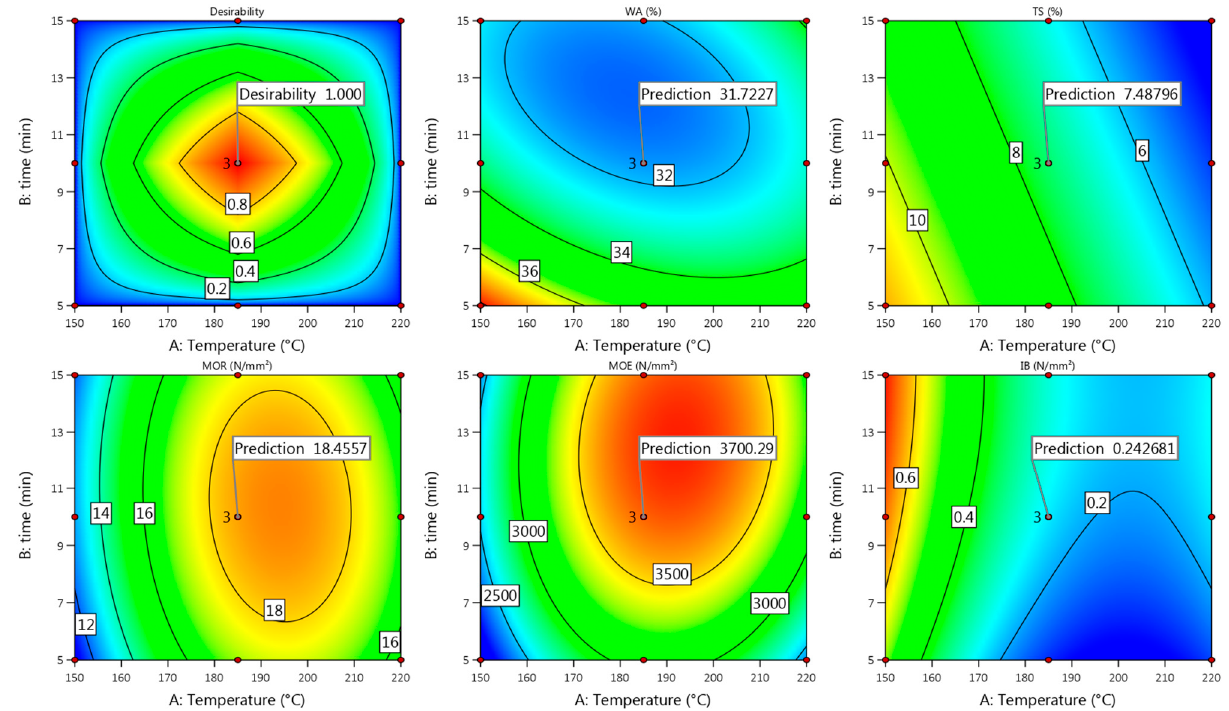
Figure 11. Contour plots with predicted values of Wh-1000 binder-less board properties at T = 185 °C and t = 10 min.